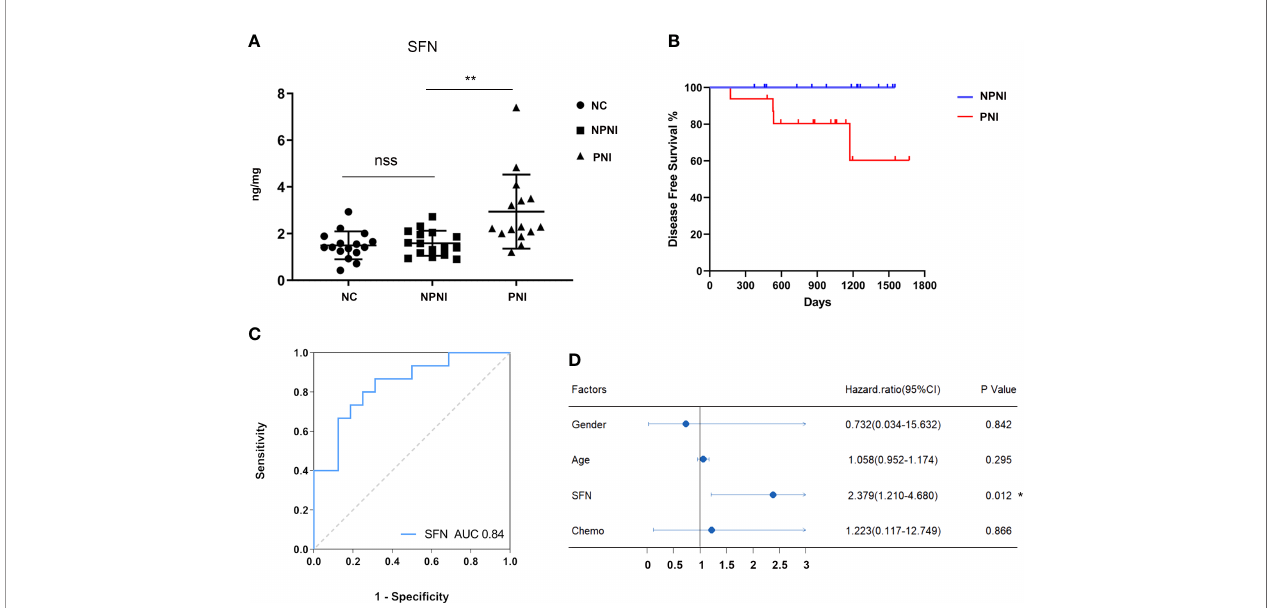
FIGURE 7 | Veri fi cation of protein expression, and translational relevance of EV SFN. (A) Serum EVs from the NPNI (n = 16), PNI (n = 16) and healthy volunteer (n = 16) groups were analyzed by ELISA using antibodies for the speci fi c detection of SFN. nss, P > 0.05, **P < 0.001 (Student ’ s t-test). (B) Kaplan – Meier analysis of disease-free survival (DFS) in CRC patients with and without PNI. (C) The diagnostic performances of EV SFN (AUC = 0.84). (D) Cox proportional hazards model indicates that SFN (HR, 2.379; 95% CI, 1.210 – 4.680; P < 0.05) is an independent prognostic factor for DFS. *P < 0.05.